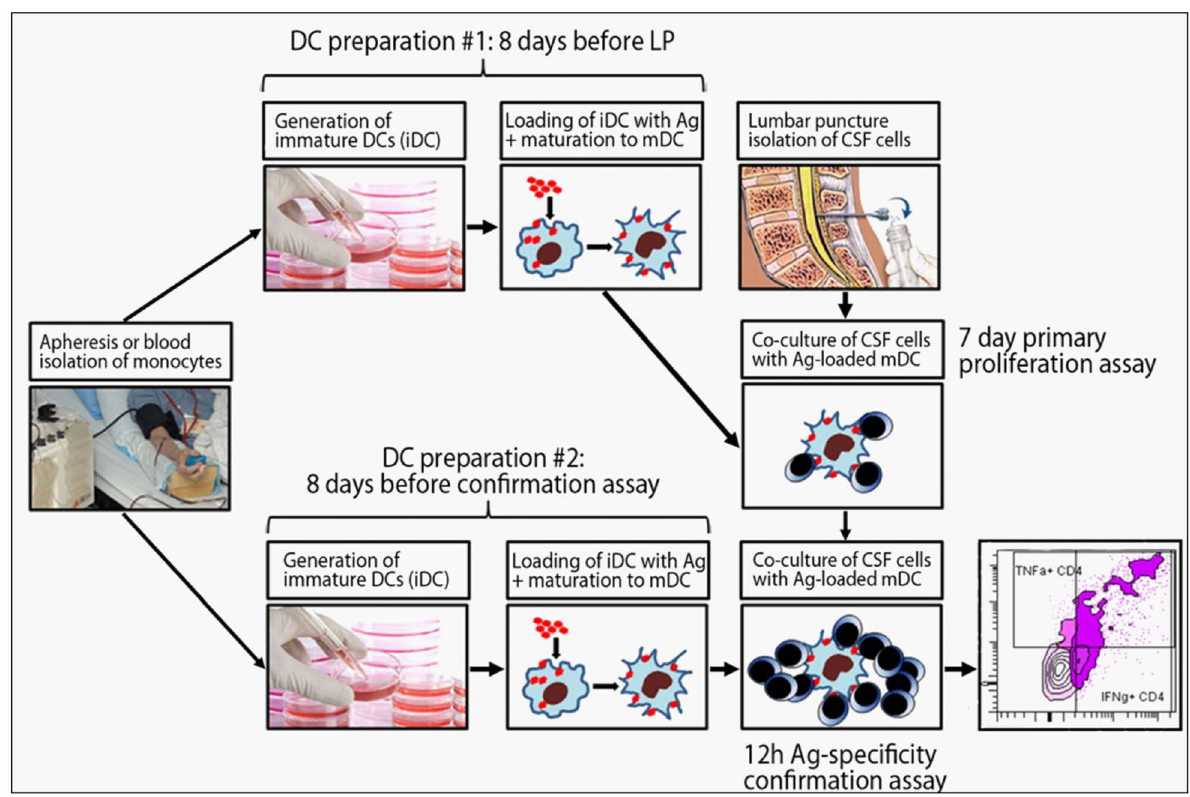
Figure 1. CSF T cell recognition and confirmation assay. PBMCs were obtained from apheresis samples or blood, and monocytes were isolated via positive selection with CD14 + magnetic beads. For the primary proliferation assay, monocytes were differentiated into immature dendritic cells (iDC). On the sixth day of culture, iDCs were loaded with selected Ag’s and stimulation cocktail was added to induce DC maturation. 48 hours later, mature DCs (mDC) were co-cultured with peripheral and intrathecal T cells. After seven days of proliferation, cultured T cells were re-stimulated overnight with newly differentiated, identically loaded mDCs. Ag-specificity was detected by flow cytometric analysis of cytokine-producing CD4 + and CD8 + T cells.